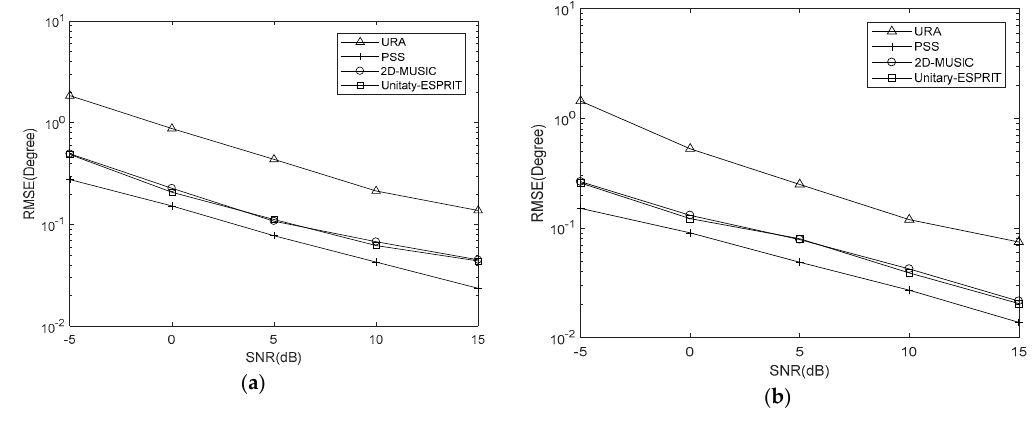
Figure 8. RMSE comparison under different SNRs with Figure 9. RMSE comparison under different SNRs with K = 10, ∆ θ = ∆ ϕ = 0.05 ◦ ( a ) azimuth ( b ) elevation.